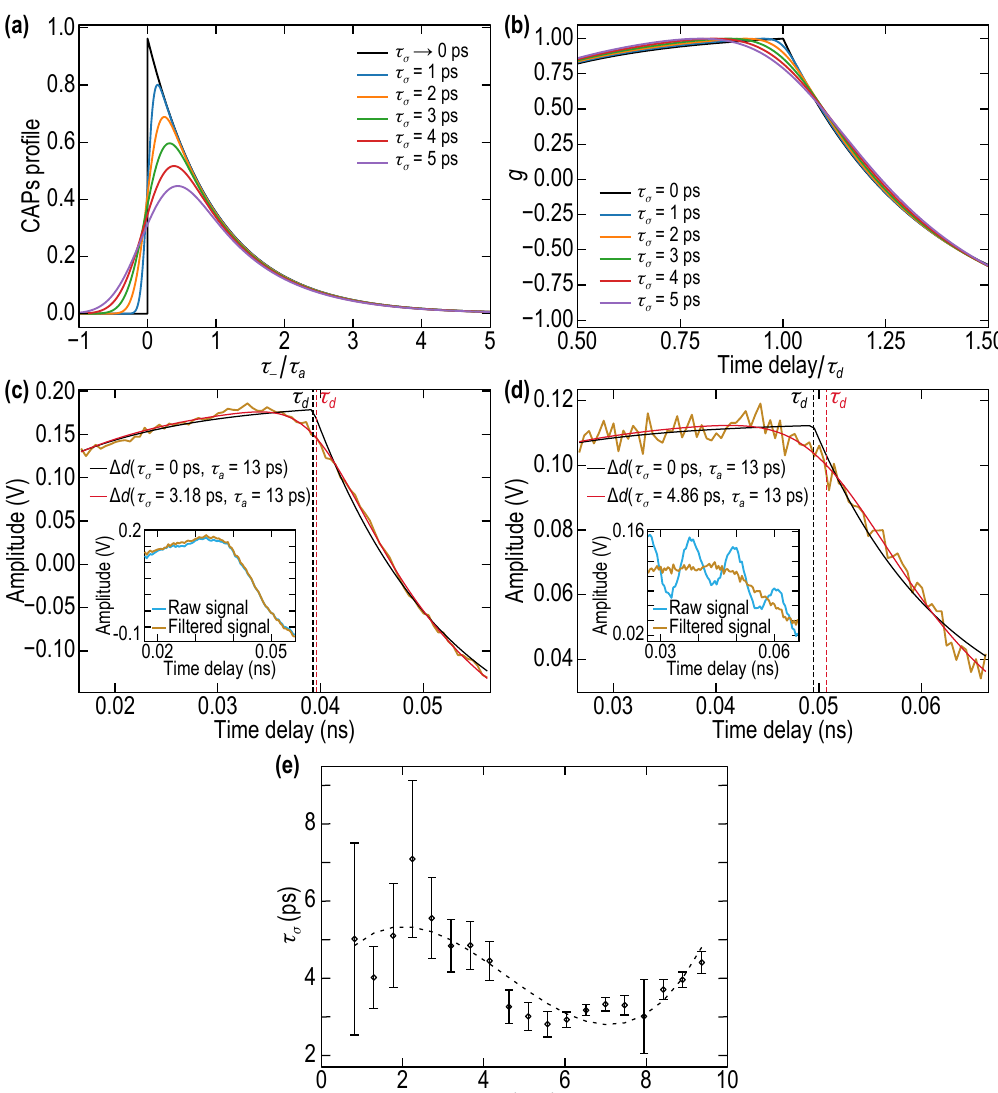
Figure 7. ( a ) Evolution of the CAPs profile associated with the increase of the surface roughness for τ σ between 0 ps (no roughness) and 5 ps. ( b ) Evolution of the temporal profile g of the thickness variations near the smoothed kink at t = τ d as a function of surface roughness for the values τ d = 40 ps and τ a = 13 ps. ( c , d ) Comparison of the filtered signals (orange) with the results of a fit with (red) and without (black) accounting for the surface roughness for two different types of signals detected with UV probe: ( c ) low and ( d ) large contribution of the Brillouin oscillations to the signal. ( e ) τ σ as a function of Y position along the graded direction of the BSTx